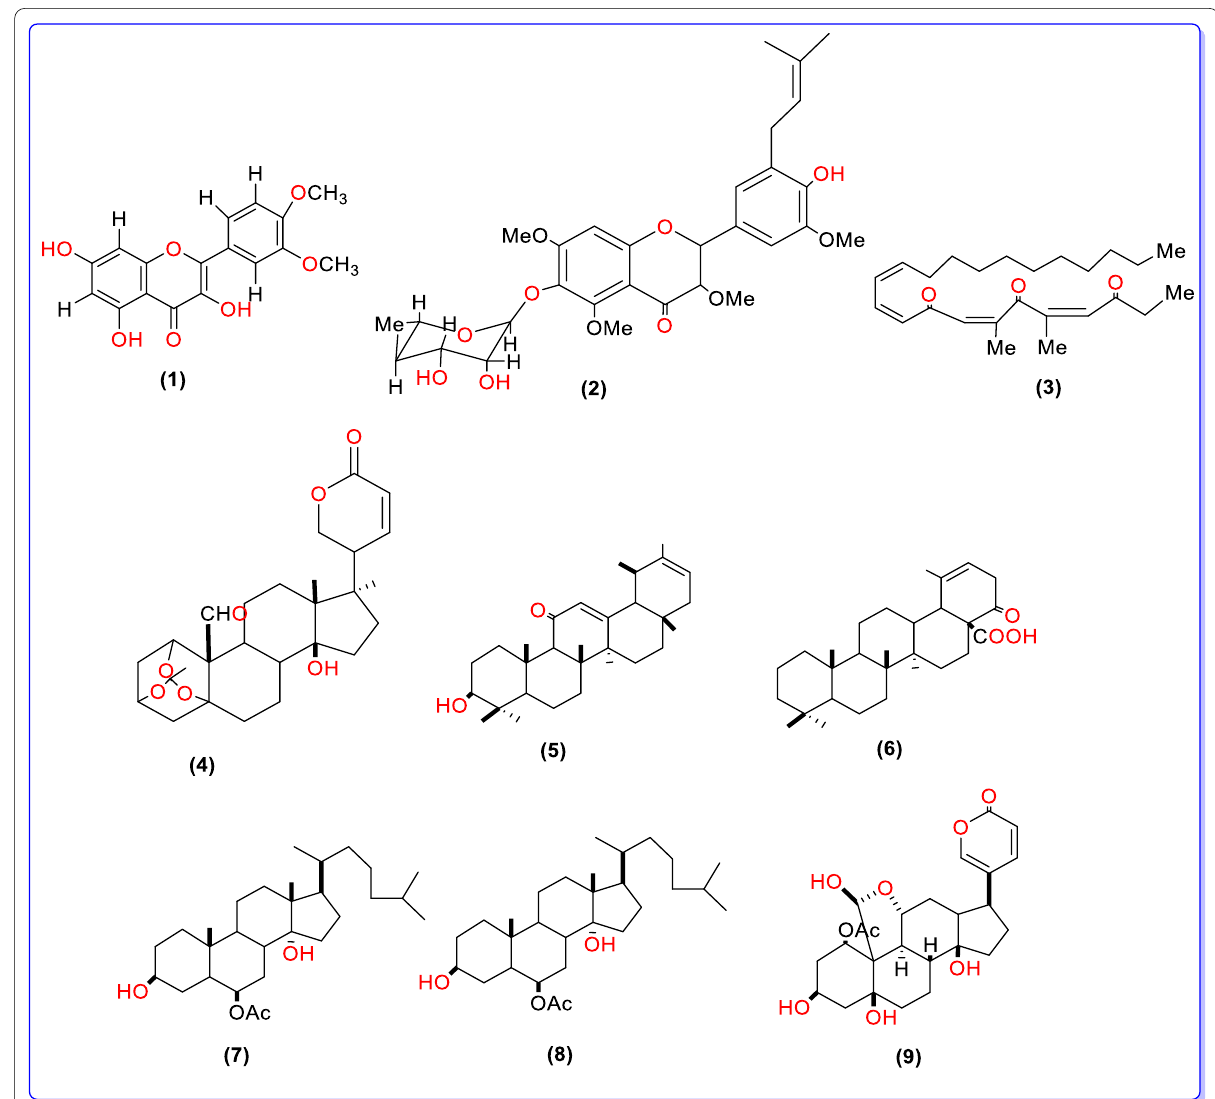
Fig. 3 Phyto-constituents of B. pinnatum. (1) 3-,4 4-dDimethoxy Quercetin (2) 4 ′ ,5-dihydroxy-3 ′ ,8-dimethoxyflavone 7-OD-glucopyradinoside (3) bryophollenone (4) bryophynol (5) bryophollone (6)) 5 ′ ,6-dihydroxy-3 ′ ,8-dimethoxyflavone 7-OD-glucopyradinoside (7) Bryophyllol (8) bryophyllin (9)